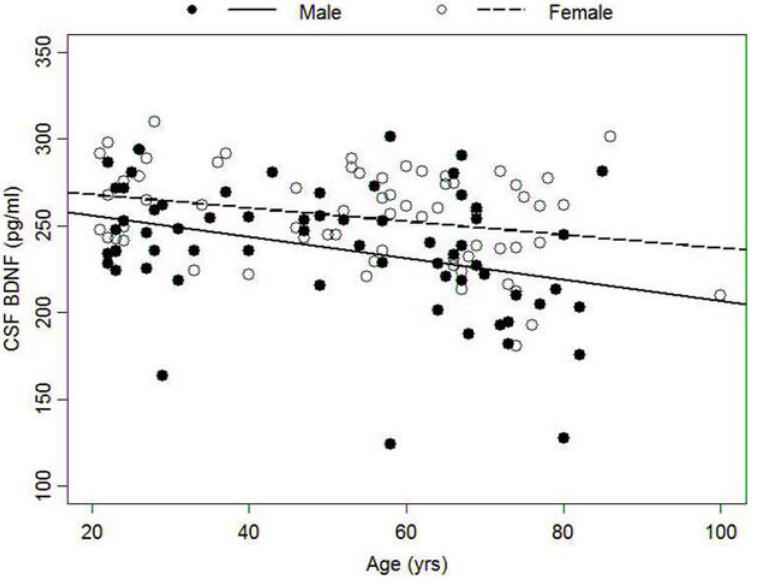
Figure 1. Cross-sectional relationships between age and CSF BDNF concentration by gender.